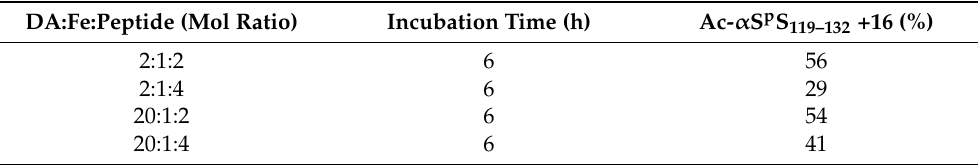
Table 2. Effect of Ac- α S p S 119–132 concentration over oxidation mechanism.